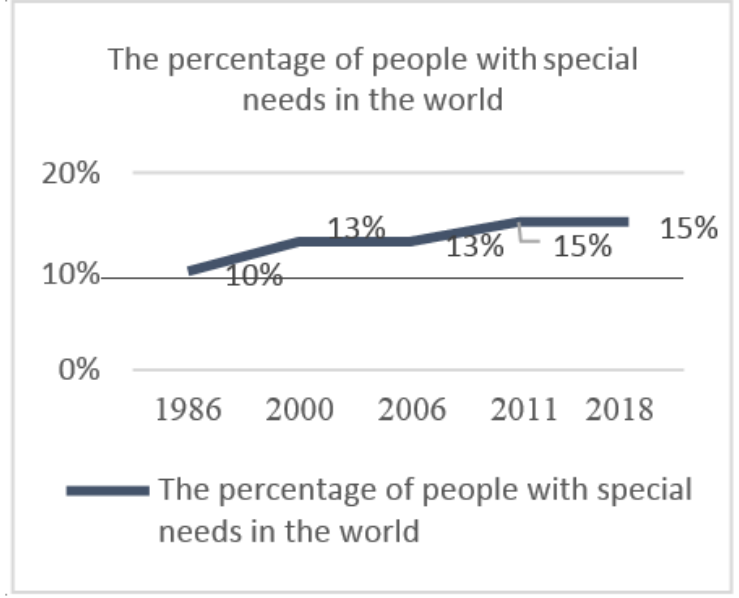
Figure 2. According to the researcher from UN